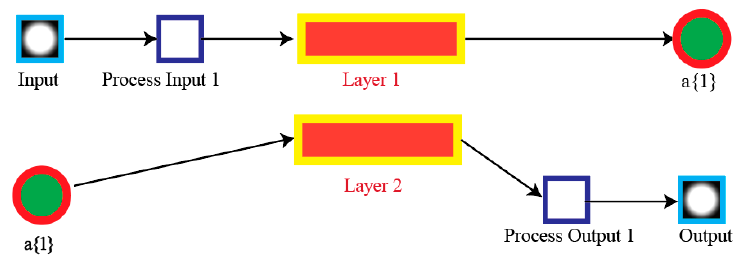
Figure 20. The internal architecture of feed-forward neural network. Table 3. Description of the implemented ANN. Artificial Neural Network Structure for NN Steps